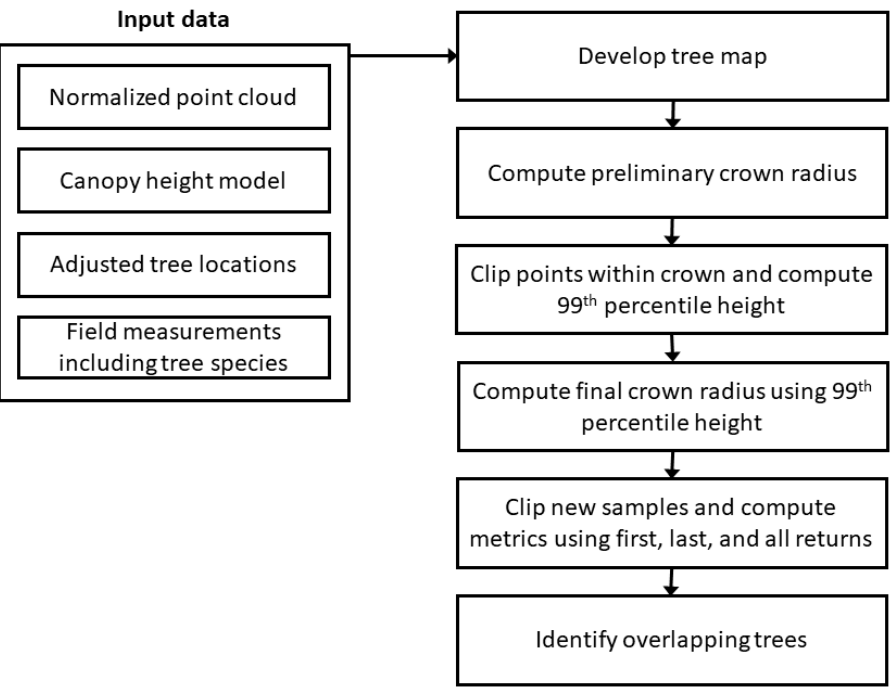
Figure 4. Flowchart depicting the process used to isolate LiDAR points for individual tree crowns to develop training data for our classification model.